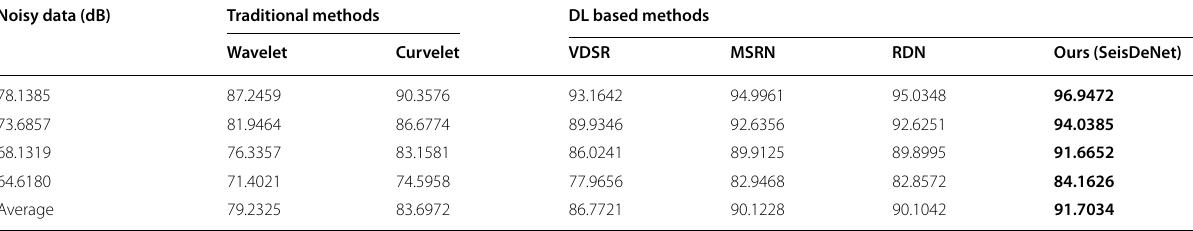
Table 1 Comparison of PSNRs for different approaches on synthetic seismic data Noisy data (dB)